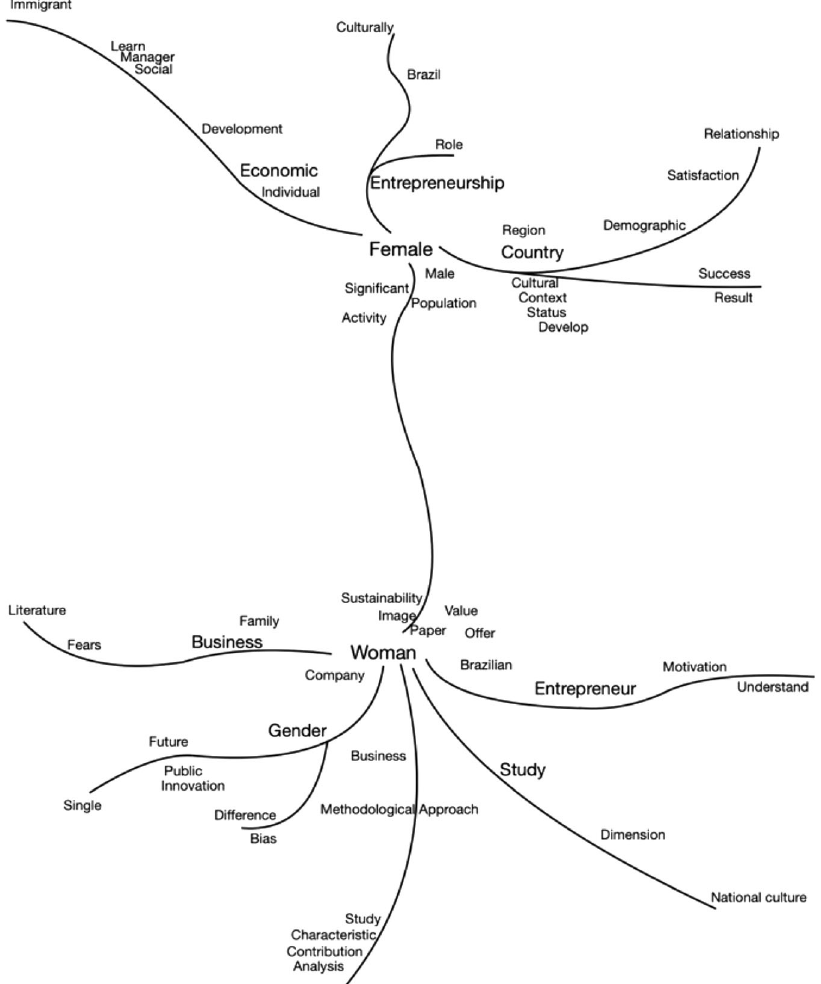
Fig. 1 Tree diagram of links between lexical classes of words in papers published in